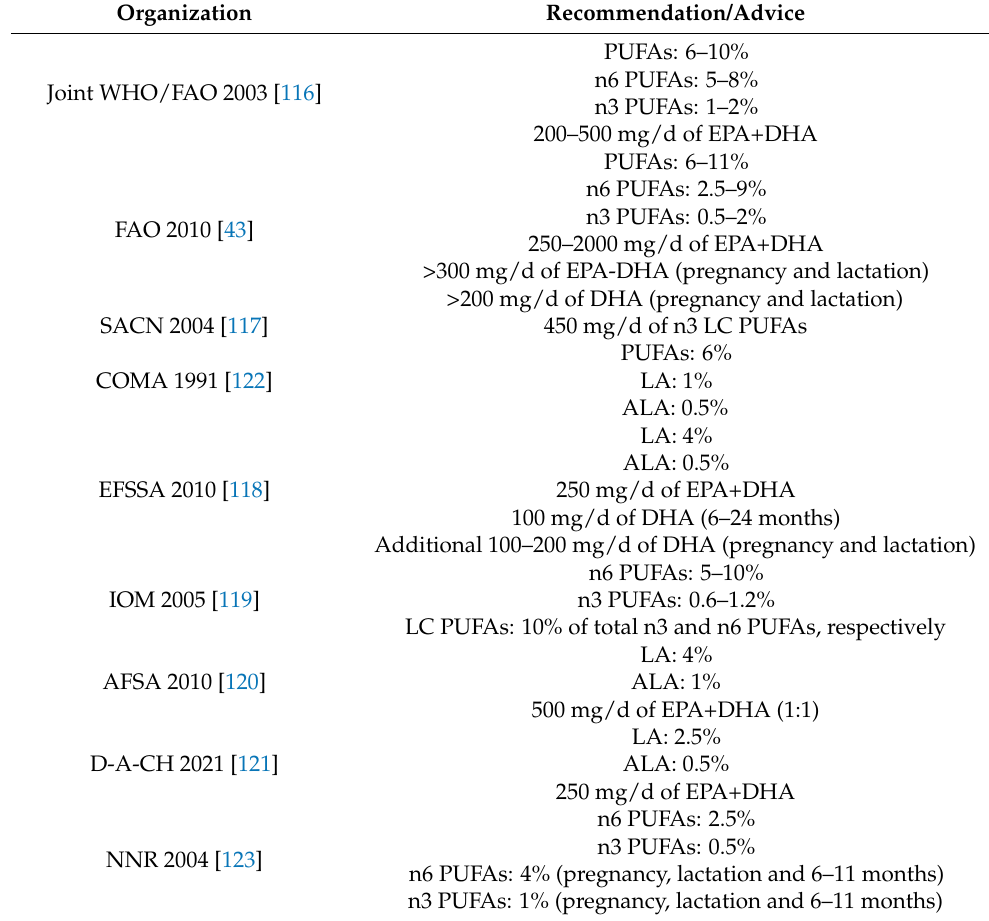
Table 3. Recommended dietary intakes of